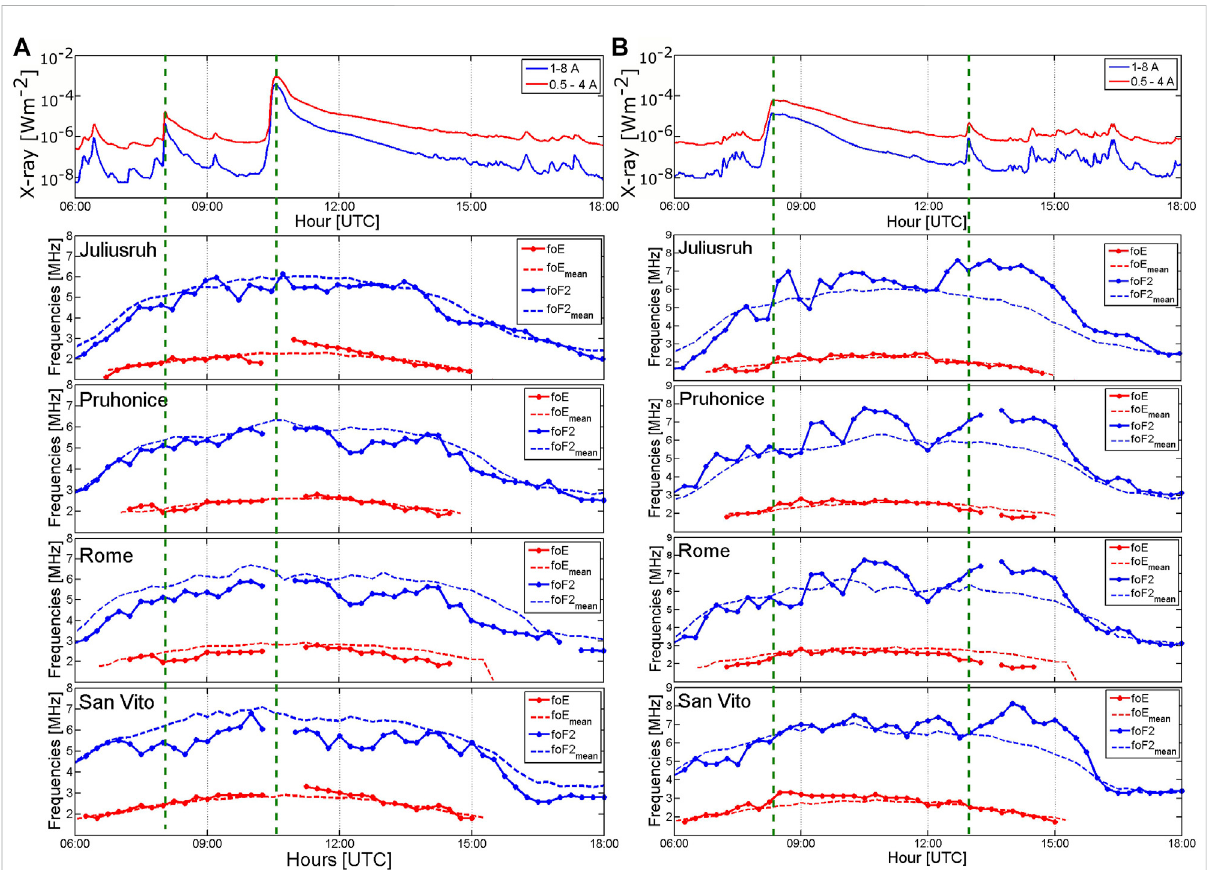
FIGURE 7 The variation of X-ray fl ux (upper plots) and the changes of foE (red line and dots) and foF2 (blue line and dots) parametersdetected atdifferent stations (from higher to lower latitudes) on 05 December (A) and 06 December 2006 (B) compared to the mean values measured during the reference days (red and blue dashed lines). The green dashed lines indicate the time of the investigated fl